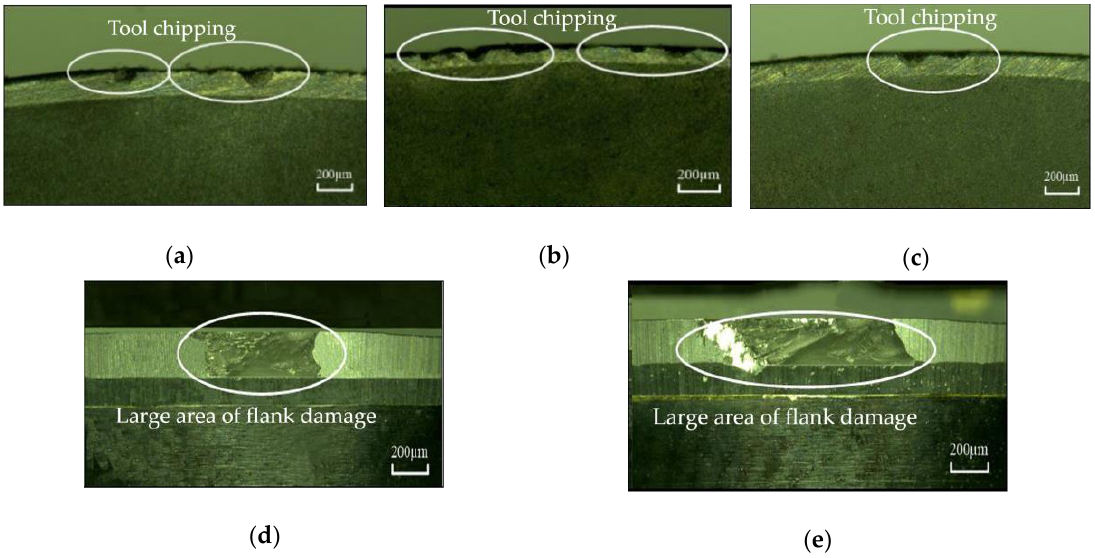
Figure 7. Tool failure form at cutting speed 150 m/min: ( a ) t = 4 min (insert 1#); ( b ) t = 6 min (insert 2#); ( c ) t = 14 min (insert 3#); ( d ) t = 28 min (insert 4#); ( e ) t = 24 min (insert 5#).